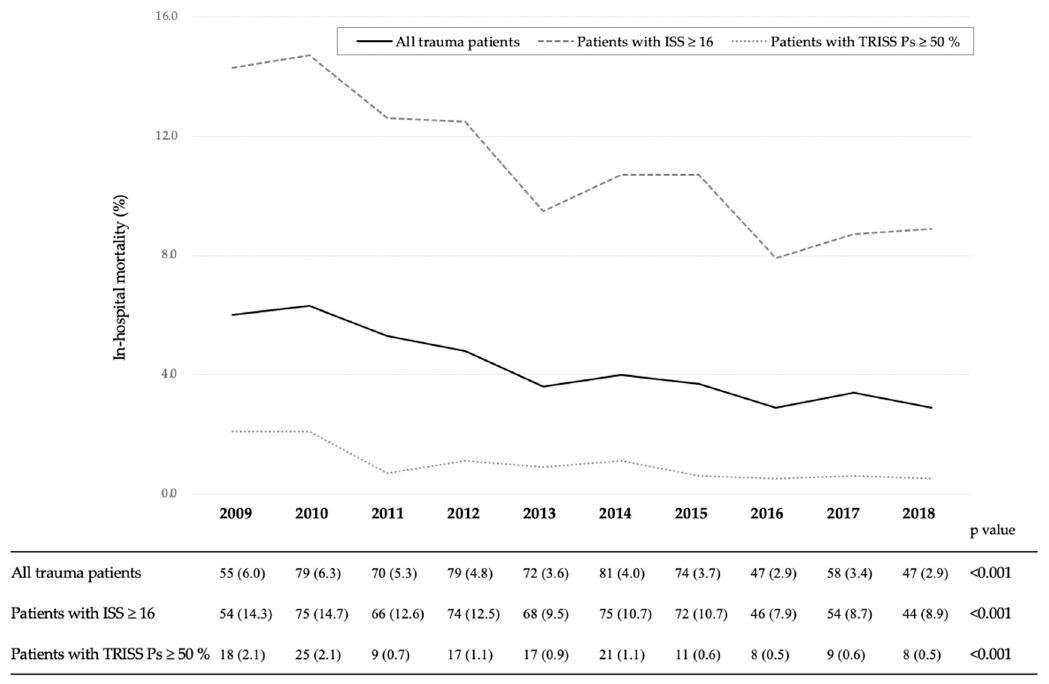
Figure 3. Yearly in-hospital mortality trends according to age group of paediatric injured patients.